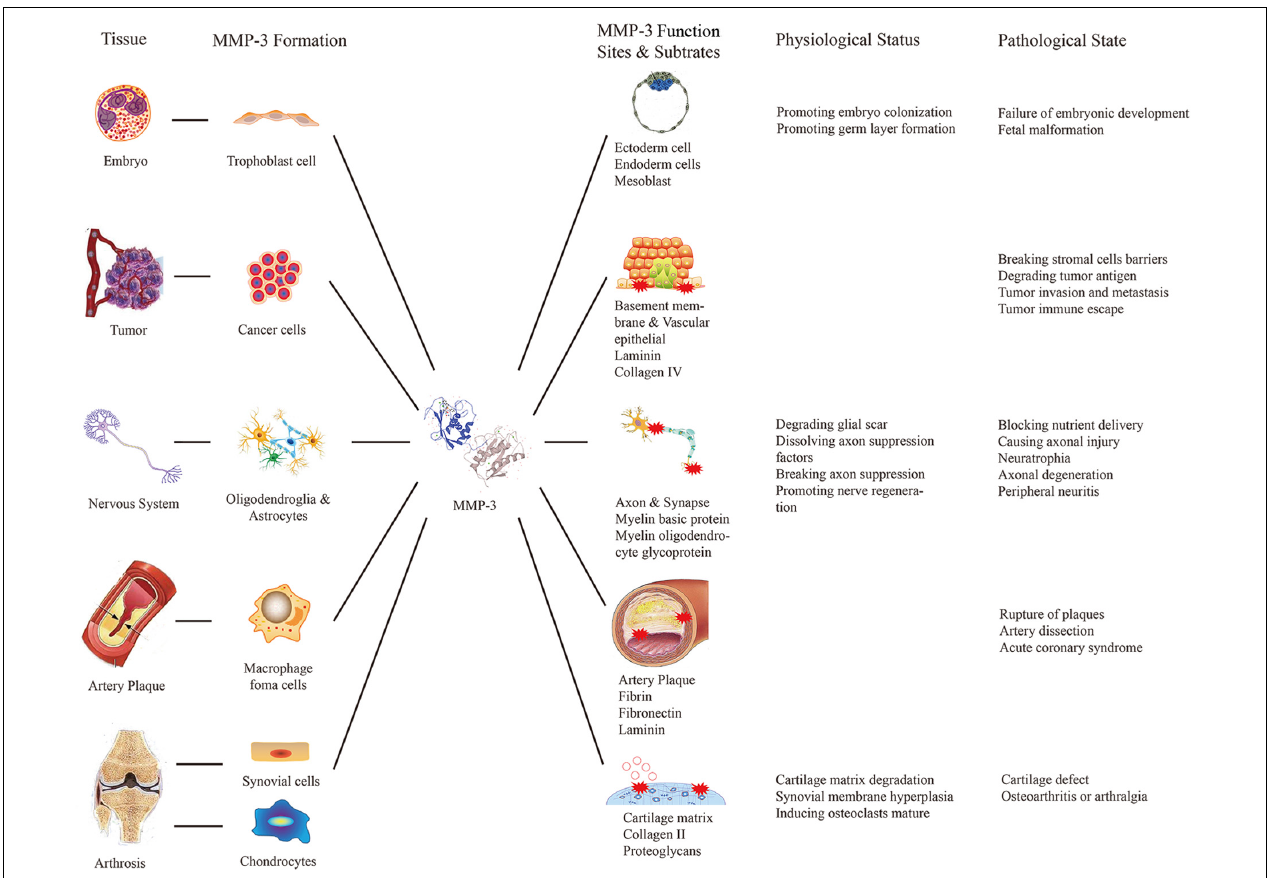
FIGURE 1 | Relationship between diseases and MMP-3 biological functions. This figure listed the source, functional sites and the positive or negative effects of the MMP-3 in some particular tissues of the human body to explain the relationship between diseases and MMP-3 biological